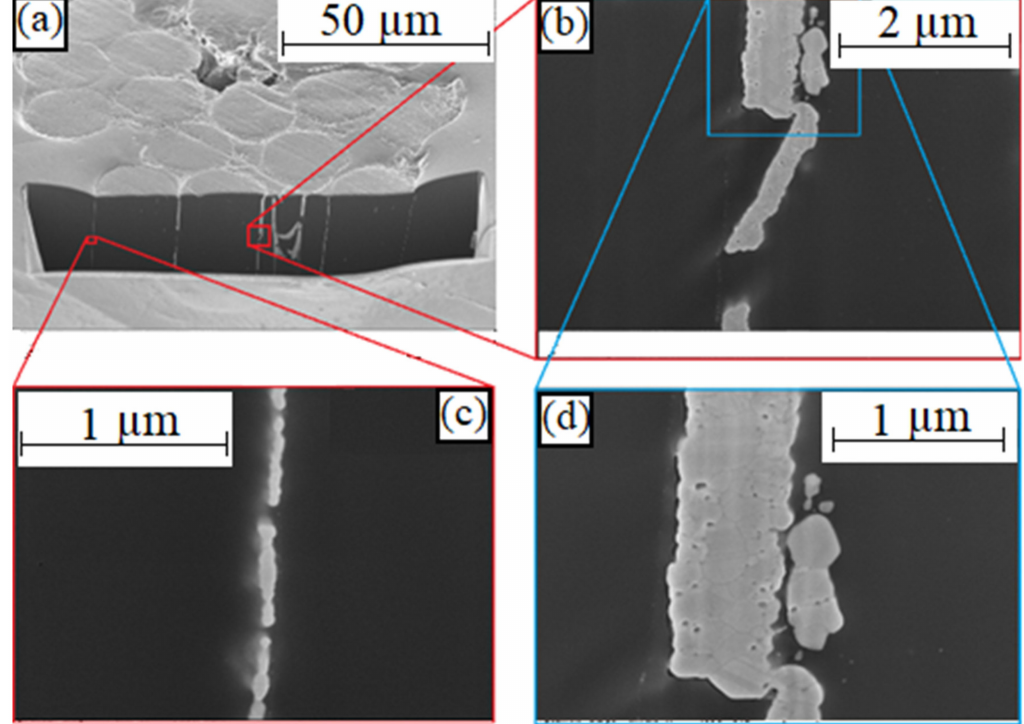
Figure 17. SEM image of a FIB cut on a tested sample with conductors made of knitted textiles at magnification of: ( a ) 1000 × ; ( b ) 20,000 × ; ( c ) 50,000 × and ( d ) 40,000 ×